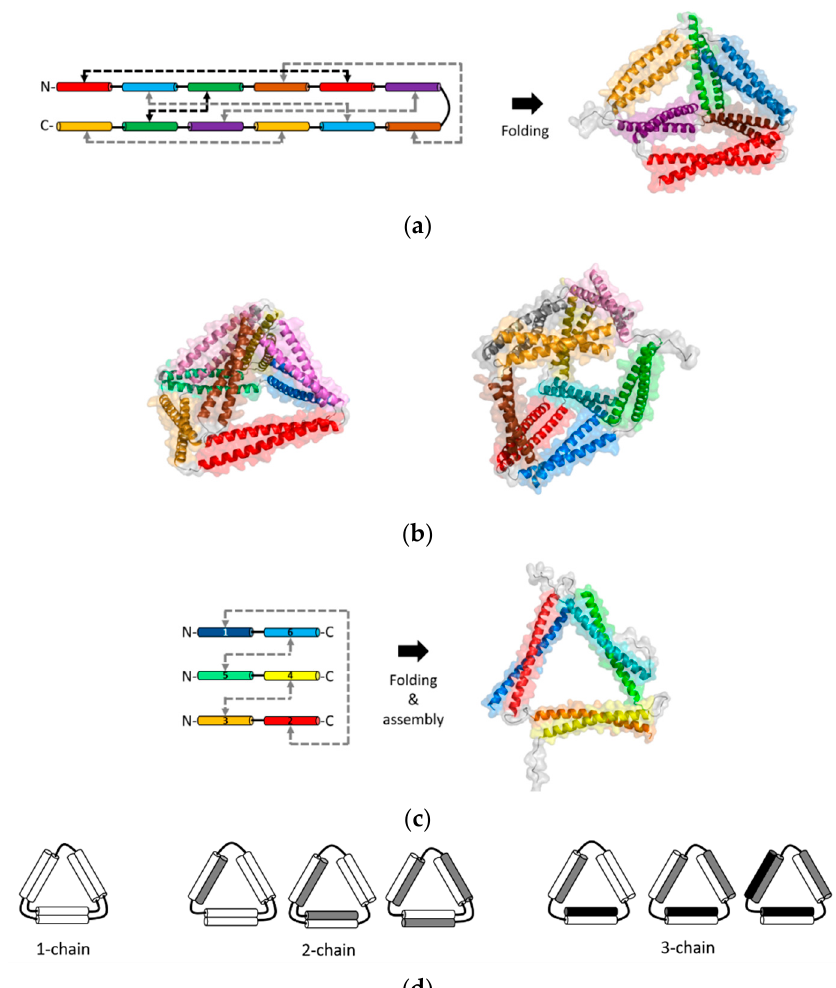
Figure 5. The coiled-coil protein origami (CCPO) nanostructures. ( a ) A single-chain CCPO fusion protein construct (left) and the structural model of the folded tetrahedron (right) [73]; parallel (gray) and antiparallel (black) coiled-coil dimerization interactions are indicated by the arrows; ( b ) structural models of the four-sided pyramid tetrahedron (left) and triangular prism (right) designed by the single-chain CCPO [73]; ( c ) the multi-chain CCPO fusion protein constructs (left) and structural models of the assembled triangle (right) [30]; ( d ) possible triangular topologies are composed of a single chain, two chains, and three chains, respectively. A three-chain topology was chosen for the design of a triangular nanostructure in panel ( c ). The structural models in panels ( a ), ( b ), and ( c ) were from best fits to the SAXS data